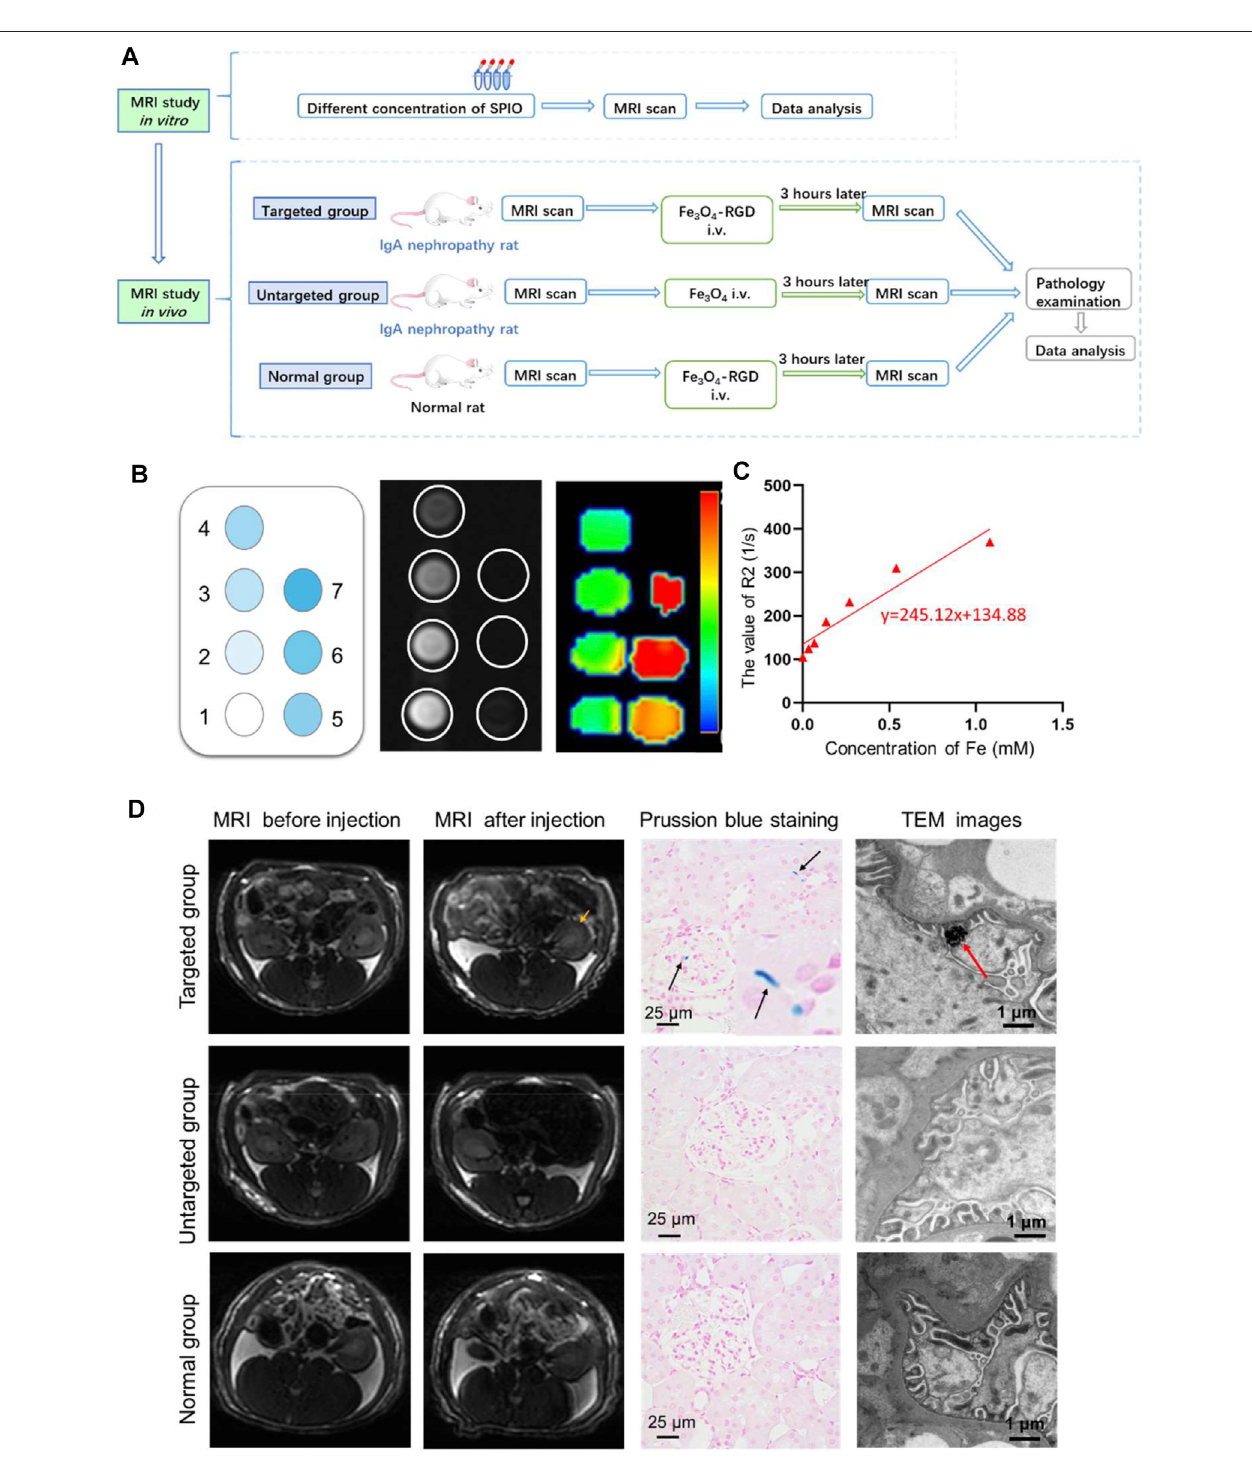
FIGURE 5 | In vivo diagnosis of IgA nephropathy by Fe 3 O 4 -RGD NPs. (A) Suggested work fl ow of Fe 3 O 4 -RGD NPs for detecting the IgA nephropathy disease by MRI technology. (B) In vitro MRI scan of Fe 3 O 4 -RGD with different concentration. (C) R2 value variation with the increased concentration of Fe 3 O 4 -RGD. (D) The targeting performance of Fe 3 O 4 -RGD for diagnosis of IgA nephropathy. Speci fi cally, T2WI images, kidney Prussian blue staining, and TEM images of rats in each group were carefully investigated.